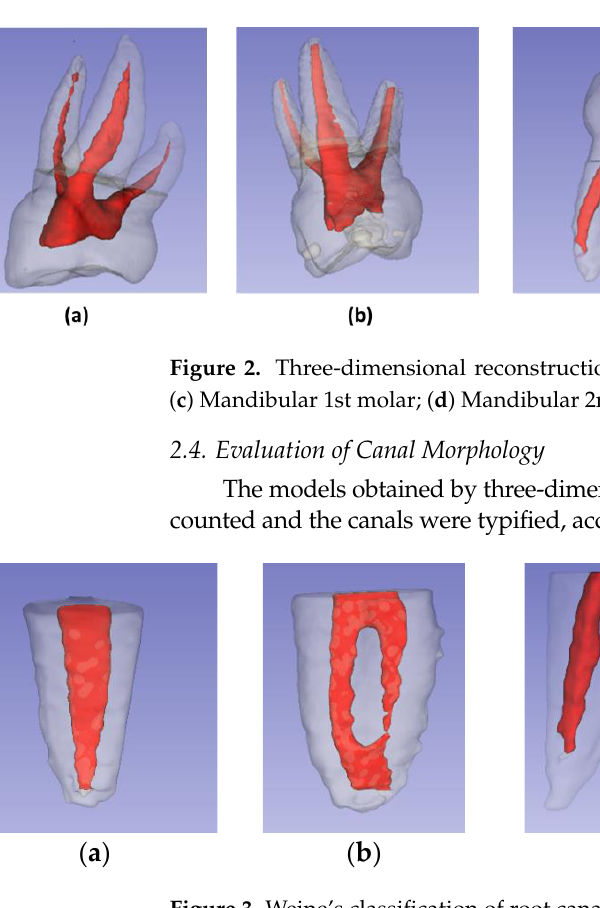
Figure 1. Examples of excluded samples: ( a ) Anterior tooth; ( b ) Root canal obliteration; ( c ) Perforat- ing root resorption; ( d ) External root resorption; ( e ) Root canal with pulp therapy.